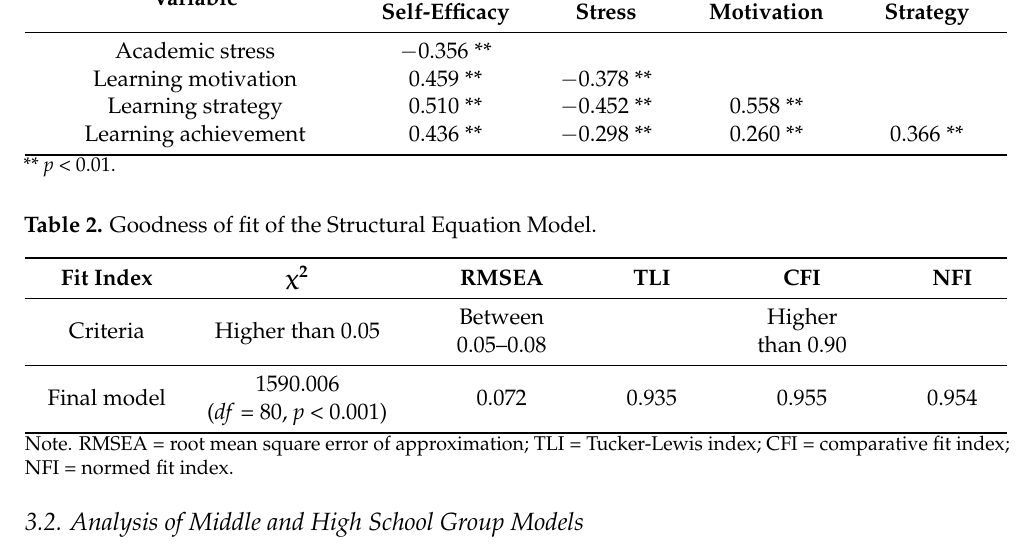
Table 1. Correlations among Academic Self-Efficacy, Academic Stress, Learning Motivation, Learning Strategy, and Learning Achievement. Variable Academic stress